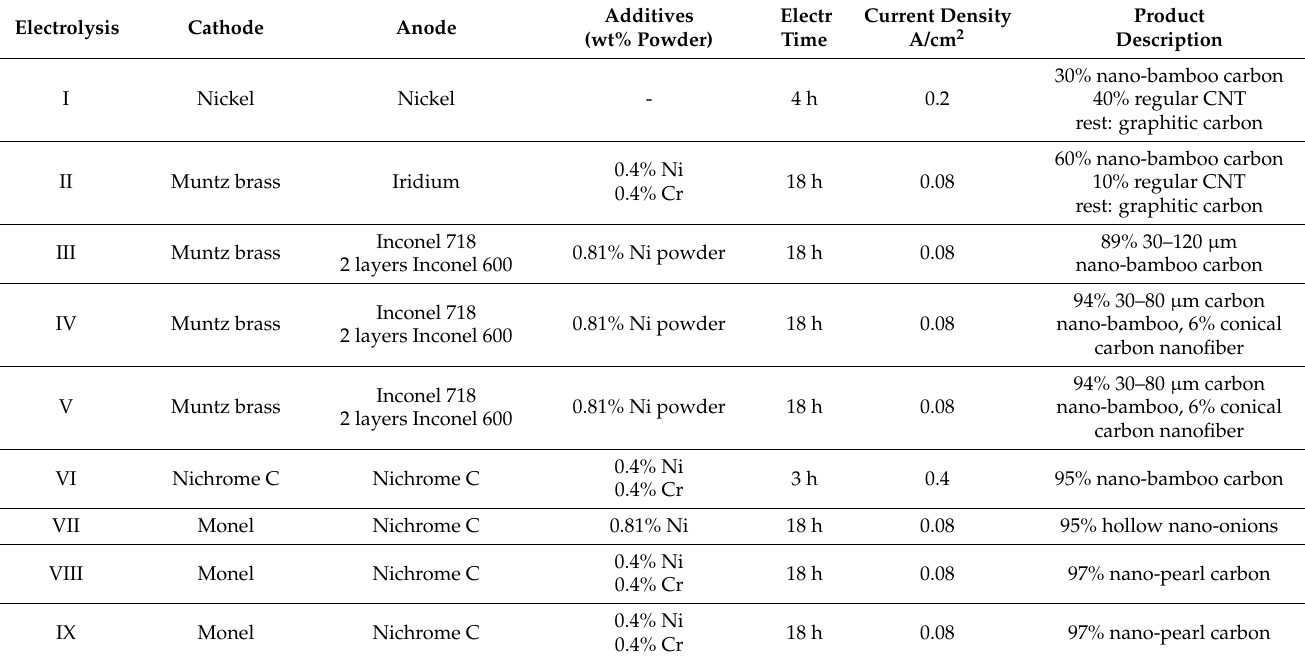
Table 2. Systematic variation of CO 2 splitting conditions in 770 ◦ C Li 2 CO 3 to optimize formation of nano-bamboo and nano-pearl carbon